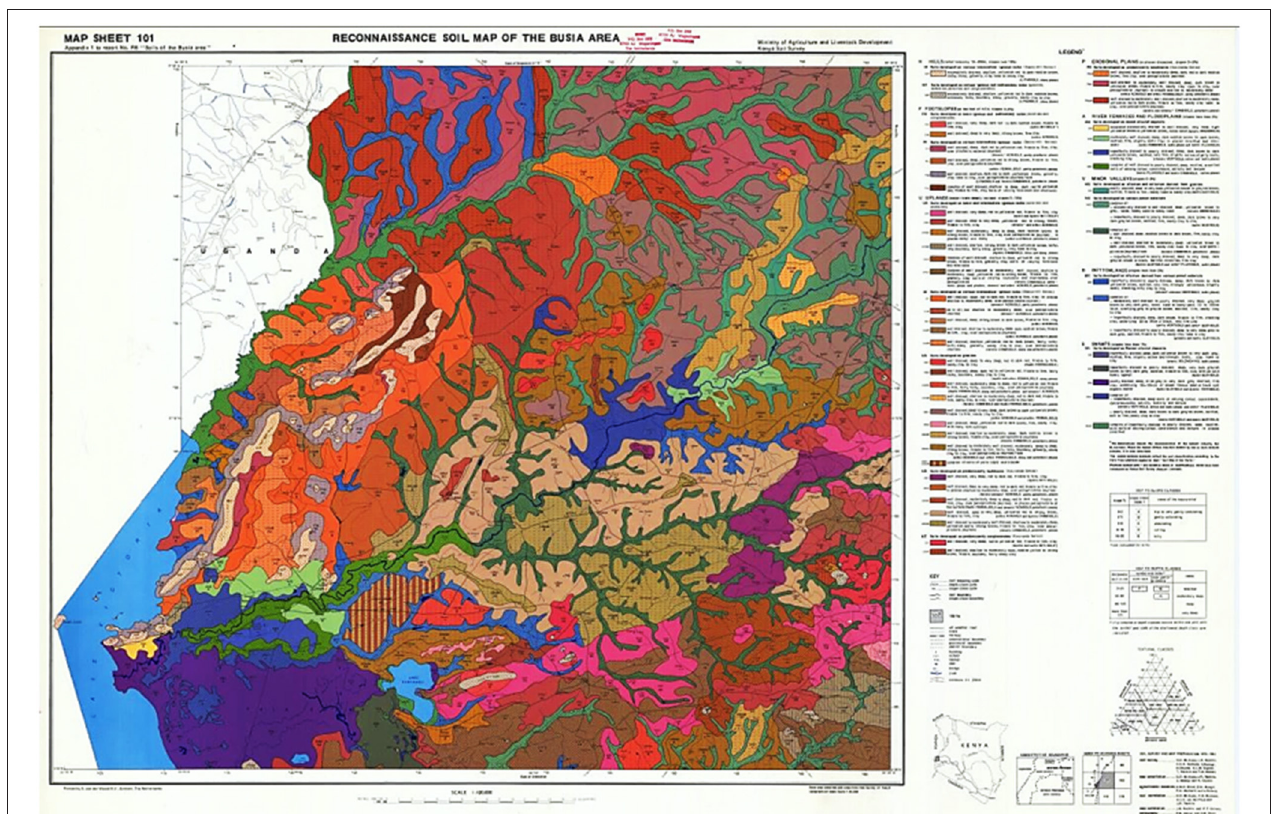
FIGURE 4 | Rescued soil map of the Busia area at a scale of 1:100,000 from Panagos et al. (40) used with permission.